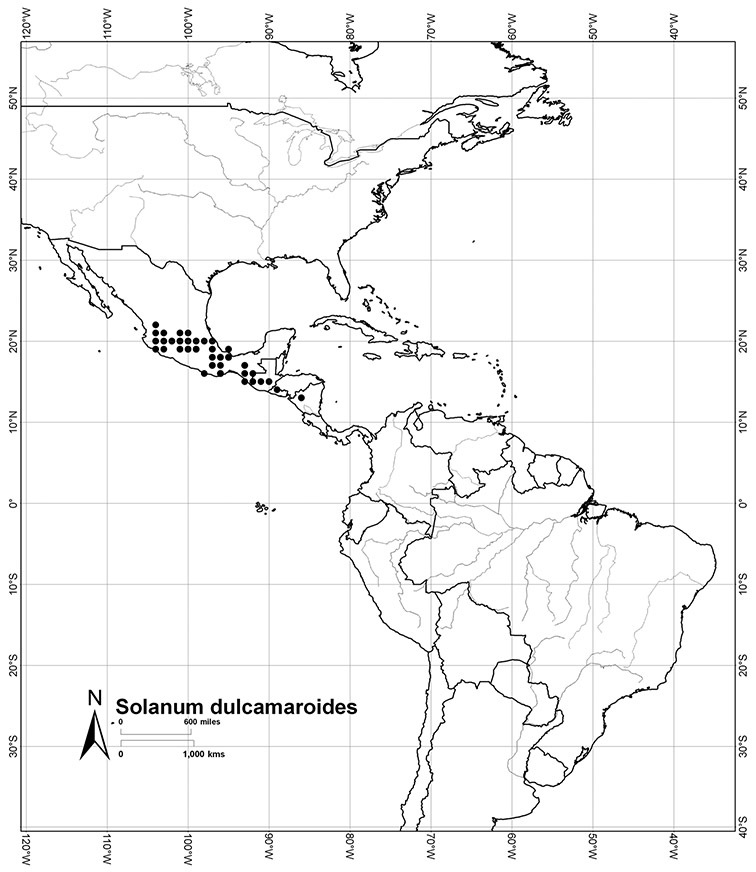
Distribution of Solanum dulcamaroides Poir.